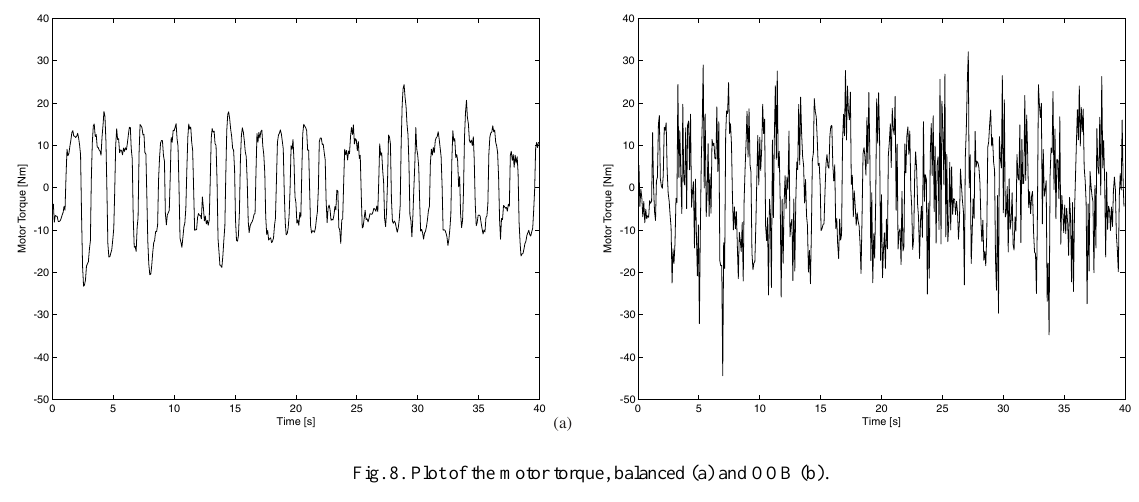
Fig. 8. Plot of the motor torque, balanced (a) and OOB